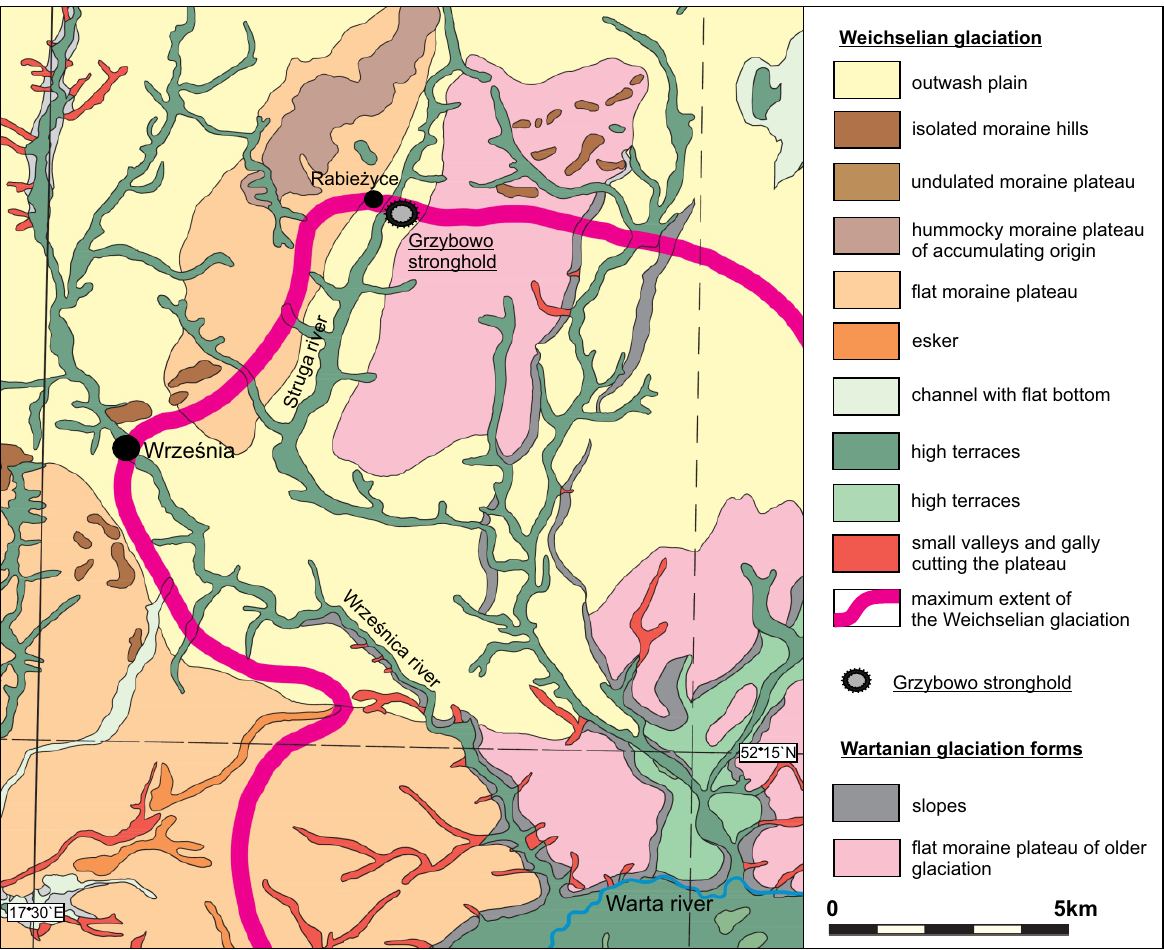
Fig. 3. Fragment of the geomorphological map of Greater Poland after karczewski et al. (2007),